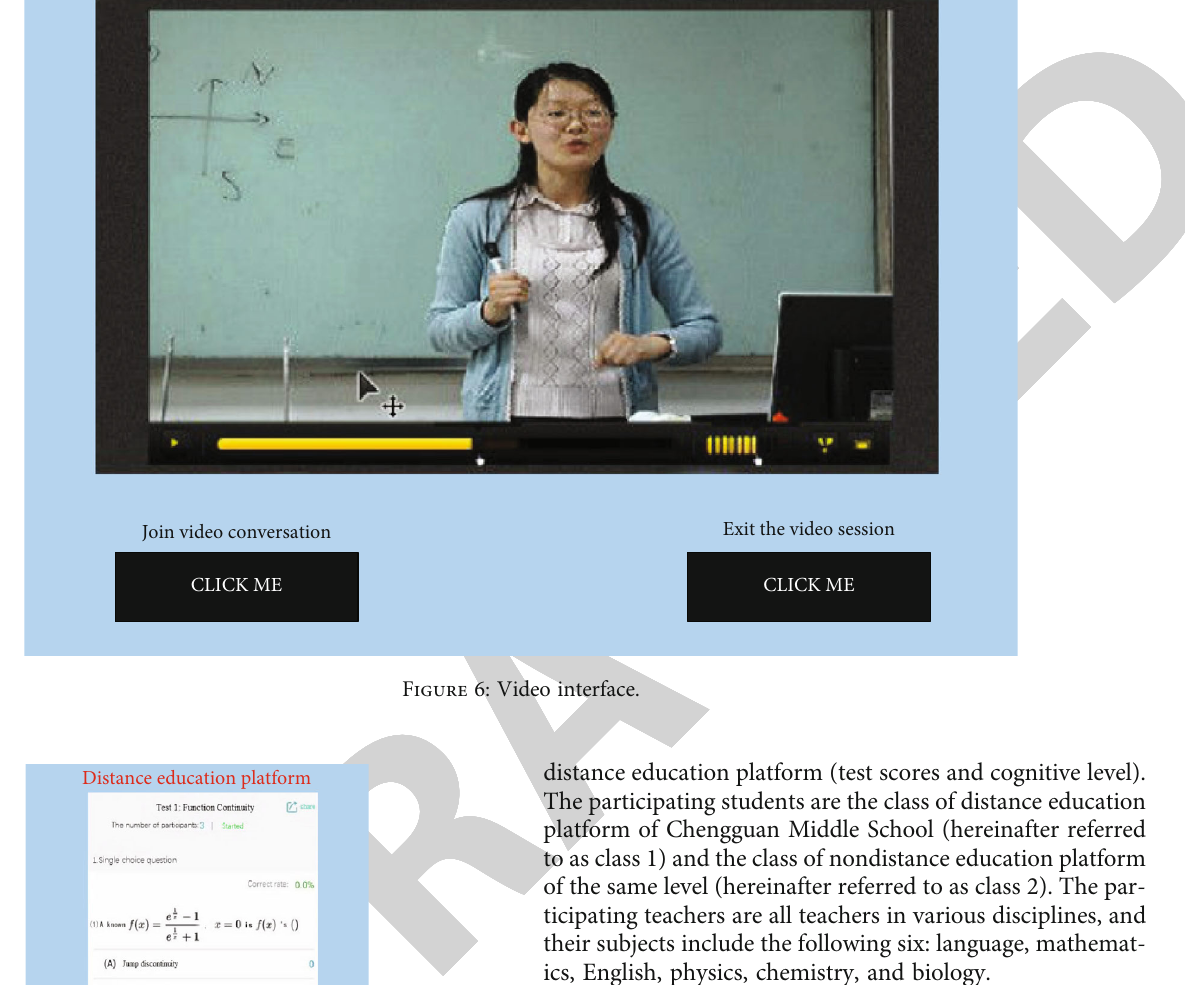
Figure 7: Math online test interface.